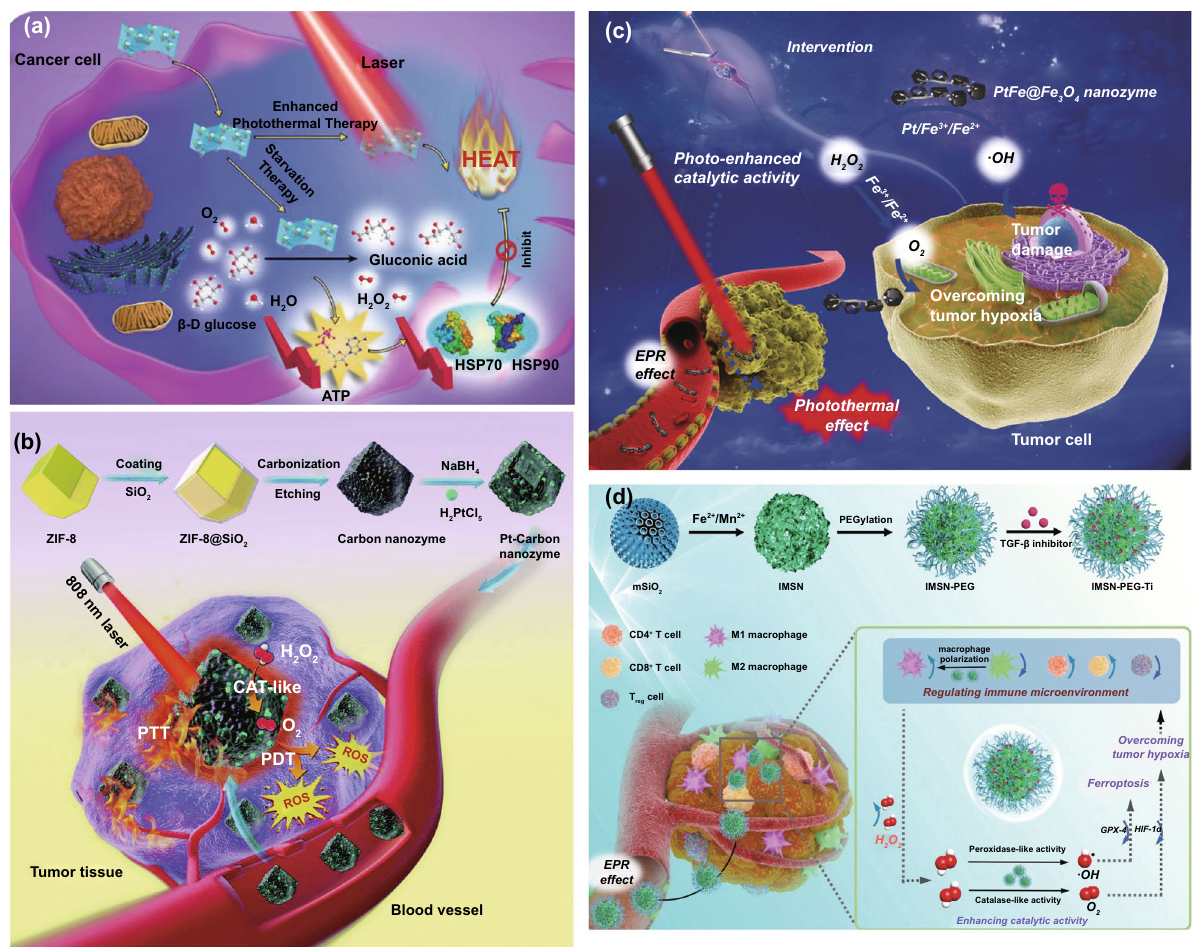
Fig. 14 a Working principle of M-NSs as GOx mimics and PTAs with effective PA imaging performance for the synergistic starvation- enhanced PTT guided by PA imaging. b Synthesis procedure and the working mechanism of Pt-carbon-integrated nanozymes for synergistic PDT/PTT cancer therapy. c Working mechanism of PtFe@Fe 3 O 4 with POD-, CAT-like activity and excellent photothermal effect under acidic TME environment for tumor catalytic therapy combined with PTT. d Illustration of the cancer immunotherapy using the IMSN ‐ PEG ‐ TI nano- platform. Adapted from a Ref. [435], b Ref. [443], c Ref. [411] with